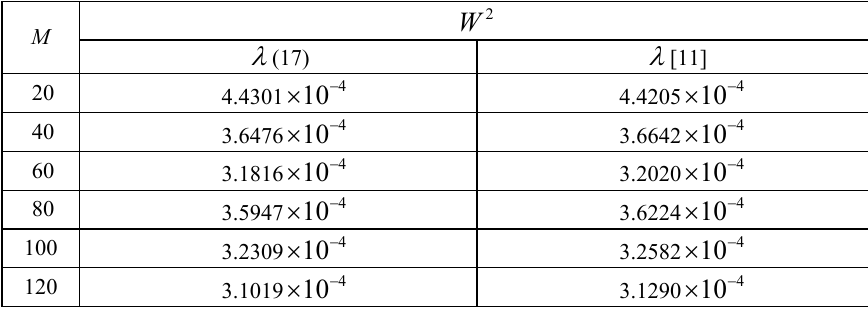
Table 5. W 2 for the largest eigenvalue when M = N